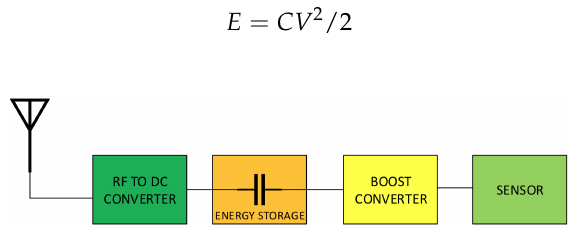
Figure 1. Block diagram of RF energy harvesting sensor node.